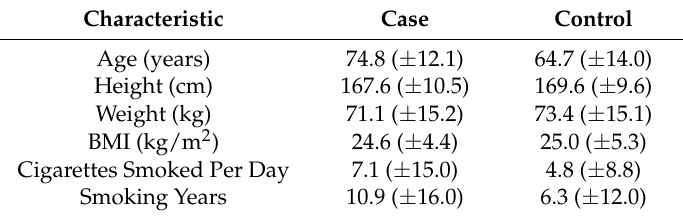
Table 1. Demographic data from sample populations of 42 cases with glaucoma, cataracts,